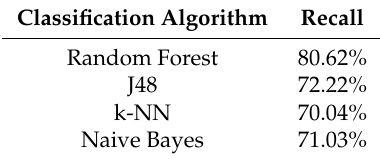
Table 3. Performance of the classification algorithms on the transportation mode